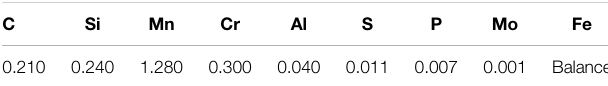
TABLE 1 | Chemical composition of the experimental steel (wt